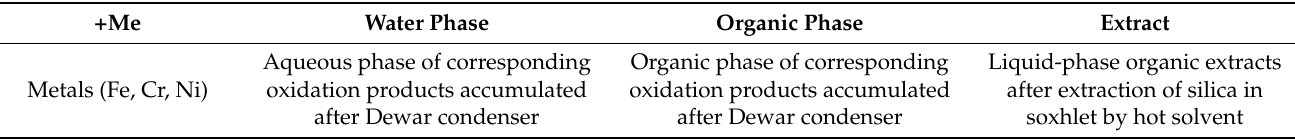
Table 1. Transcription of shortcuts used in FT-IR and GC-MS spectra.